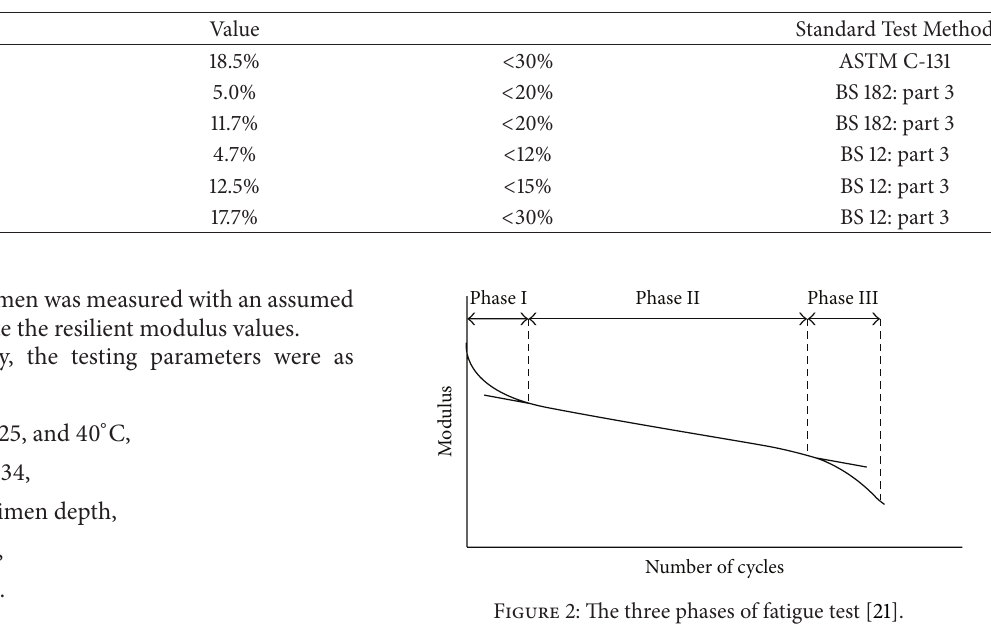
Table 3: Physical properties of the crushed aggregate.